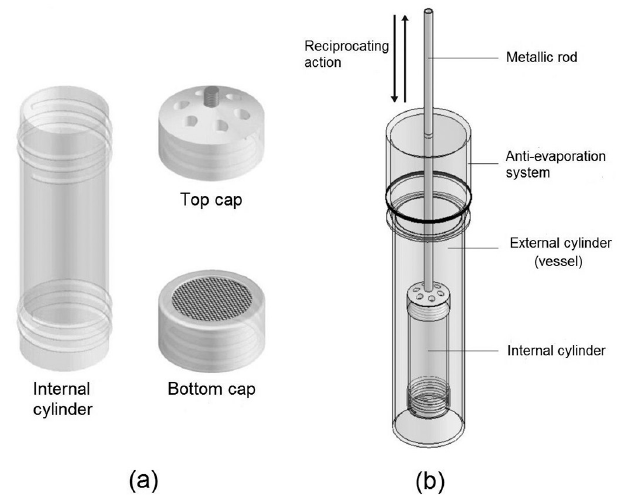
FIGURE 1 – Reciprocating cylinder apparatus: (a) Internal cylinder and its top and bottom caps (b) illustration of the internal cylinder coupled to the rod inside the external cylinder